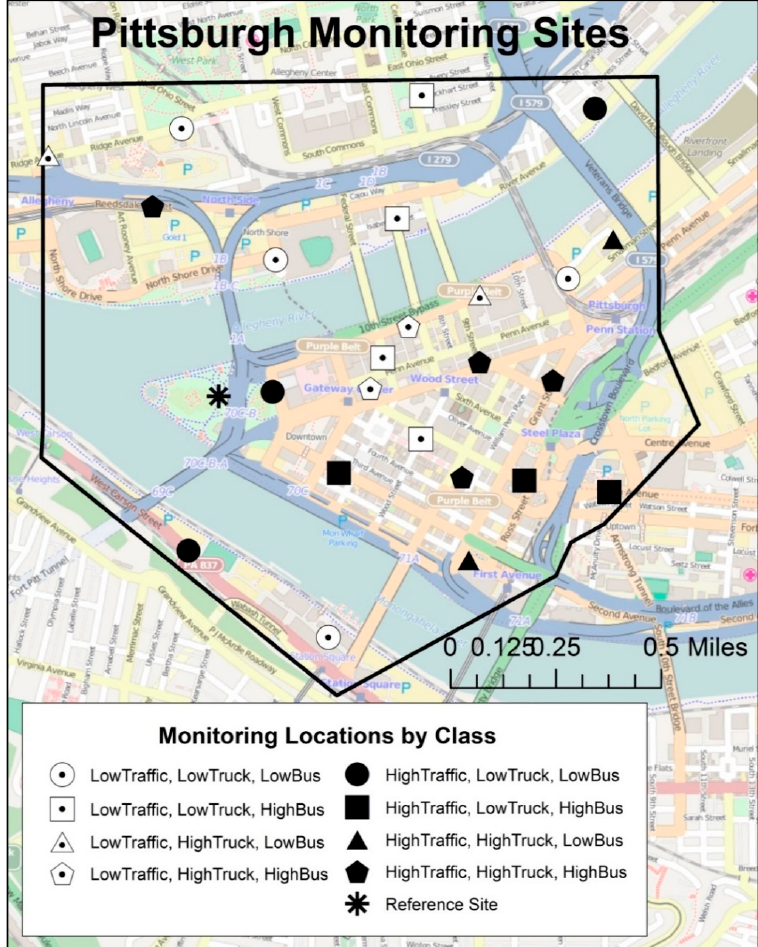
Figure 1. Downtown Pittsburgh monitoring locations ( n = 24) and reference site by class dichotomization (total traffic density, truck traffic density, bus route density). Rural upwind reference site to the west (~14.5 km) of the study area is not shown.